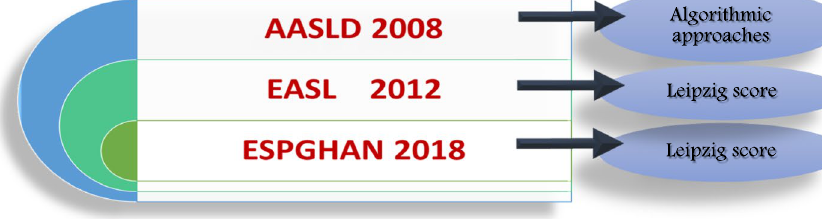
Fig. 1 The most accepted algorithmic/scoring approaches for WD